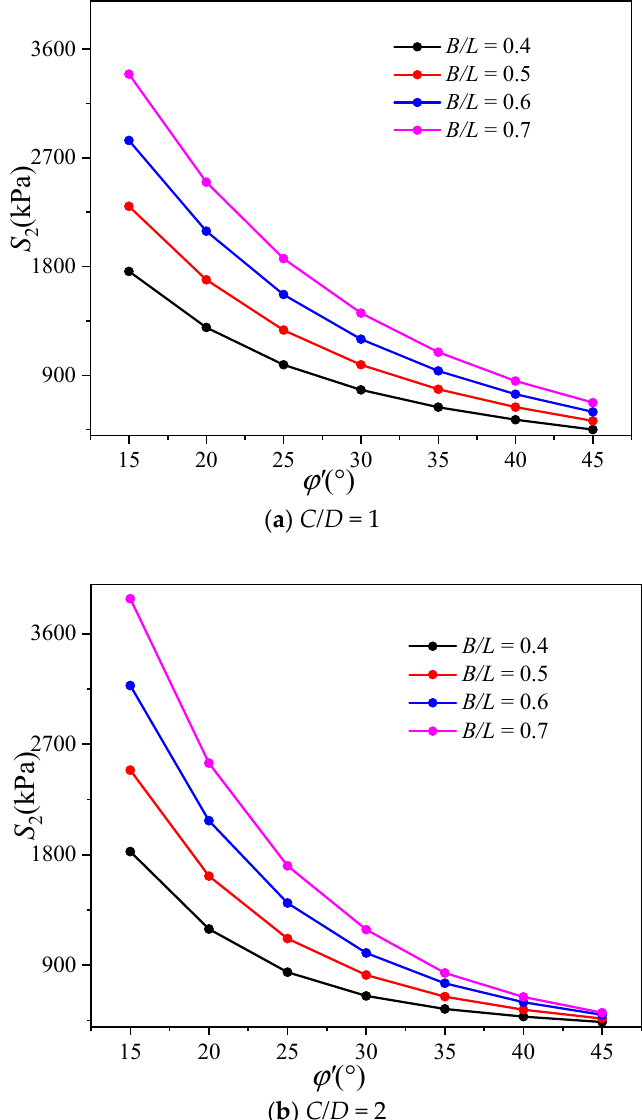
S depending on ϕ′ . 2 2 C D = ), the proposed model predicts that ϕ′ s . 2